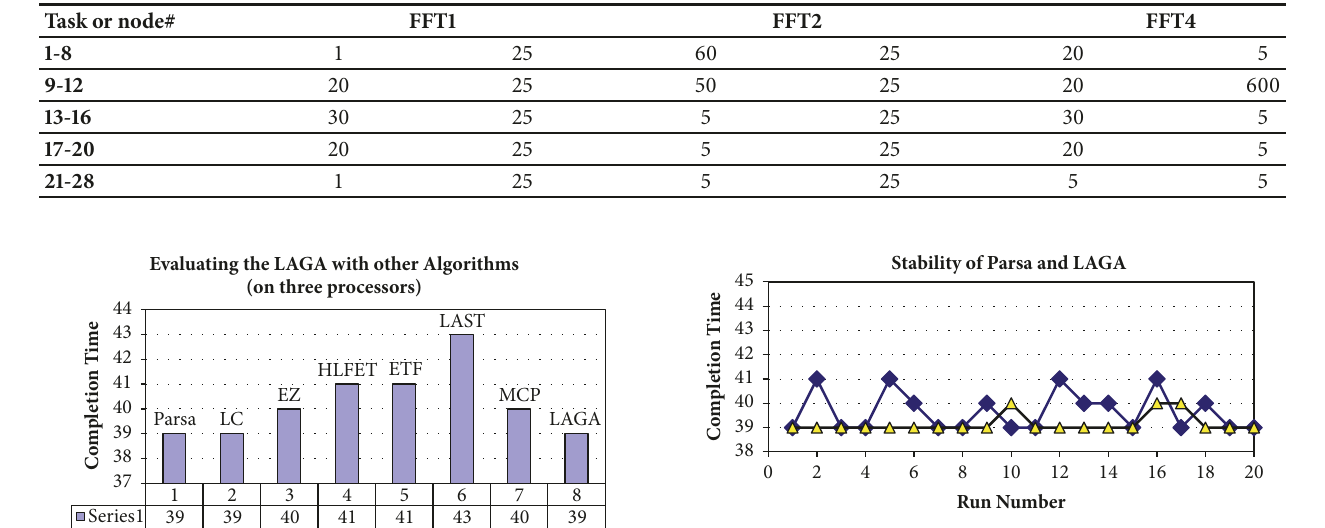
Table 4: Fast Fourier Transform Task Graphs (FFT).